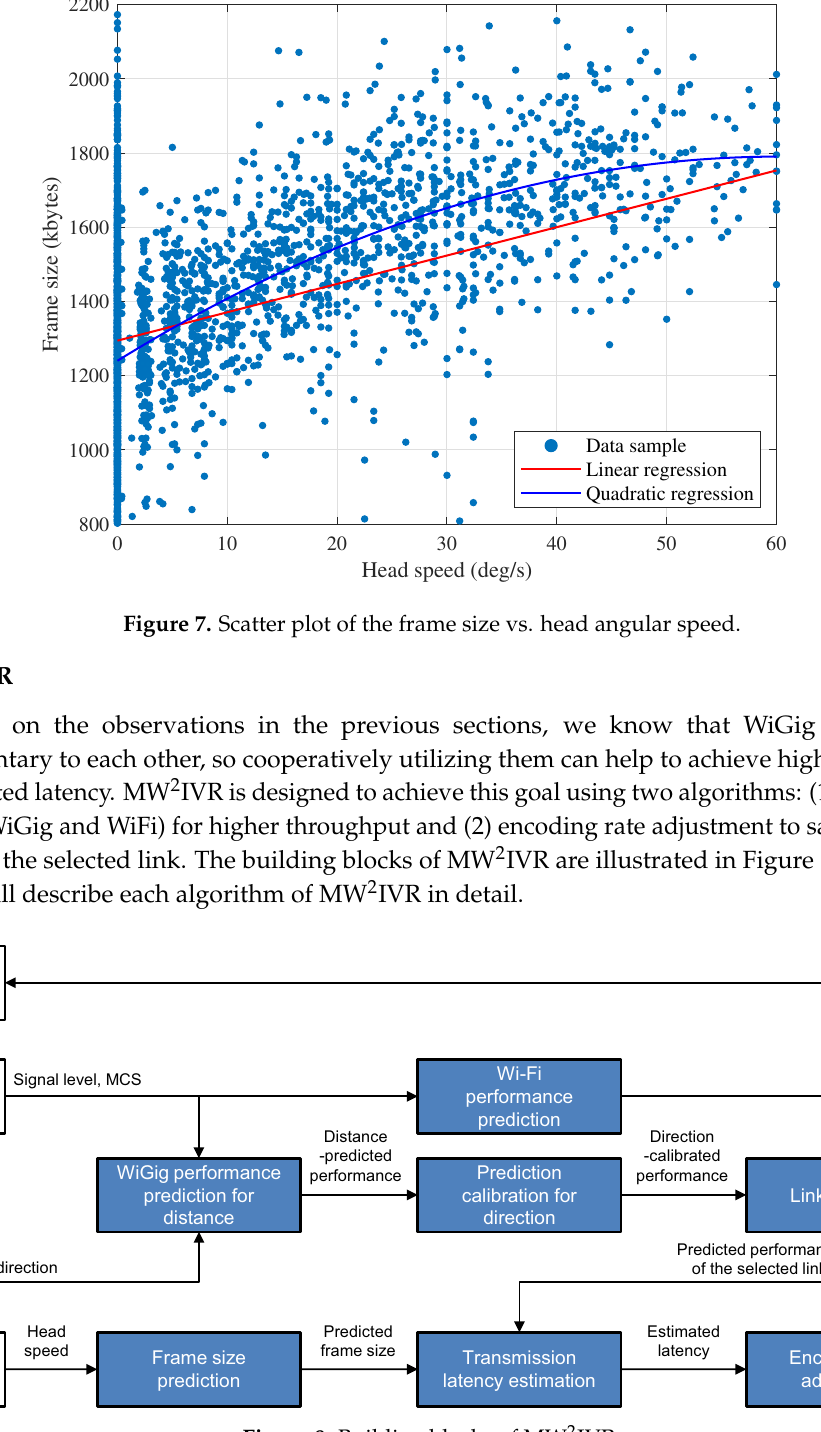
Figure 8. Building blocks of MW 2